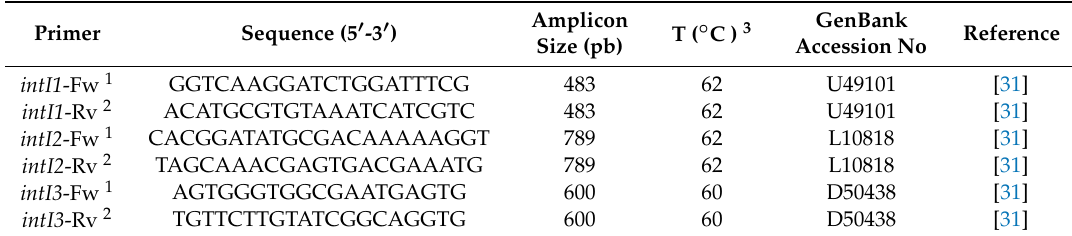
Table 2. Primers used for the detection of